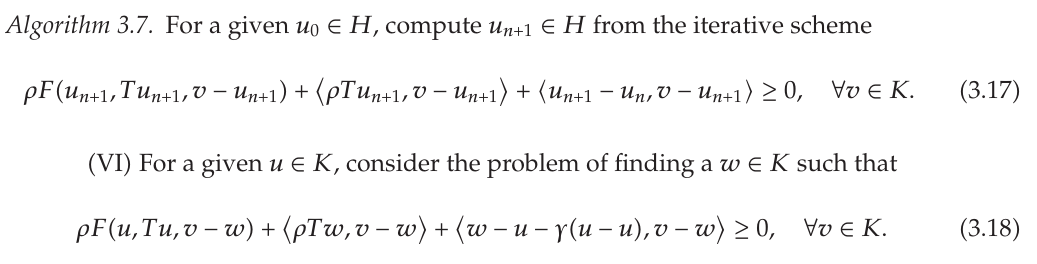
Algorithm 3.7. For a given u 0 ∈ H , compute u n (cid:7) 1 ∈ H from the iterative